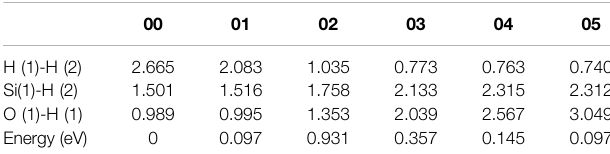
TABLE 4 | H-H, Si-H and O-H bond lengths and the energies of the states in P b1 depassivation